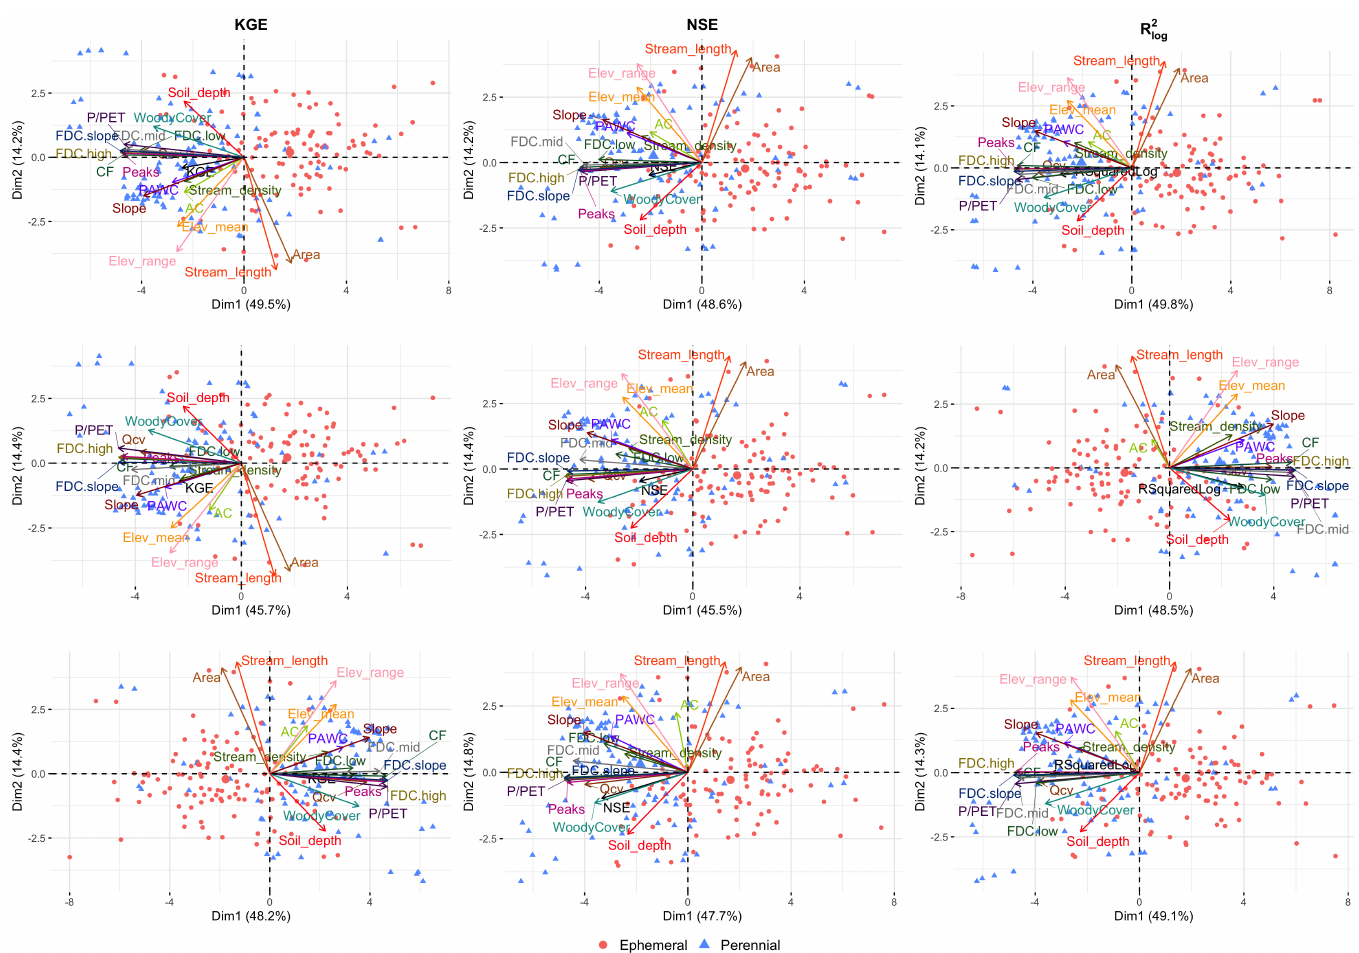
Figure 4. Biplots of the principal component analyses for each model and objective function. The models are in rows and the objective functions are in columns. The R 2 objective function vectors are labelled as RSquaredLog inside the log